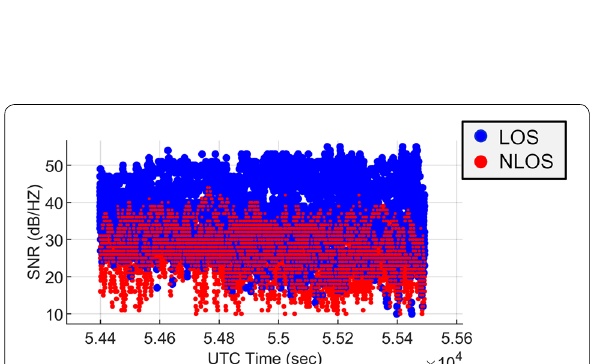
Fig. 4 Demonstration of SNR of LOS and NLOS in an urban